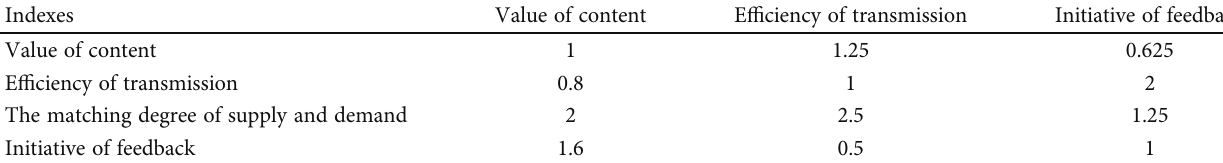
Table 2: Subjective evaluation matrix of indicators.